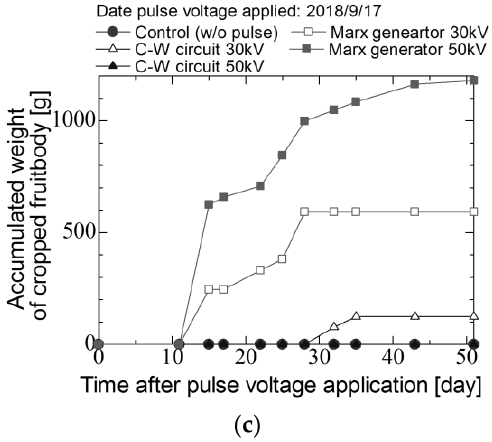
Figure 9. Diurnal change of the accumulated weight of fruitbody of L. edodes in ( a ) 2nd flush, ( b ) 3rd flush and ( c ) 4th flush.